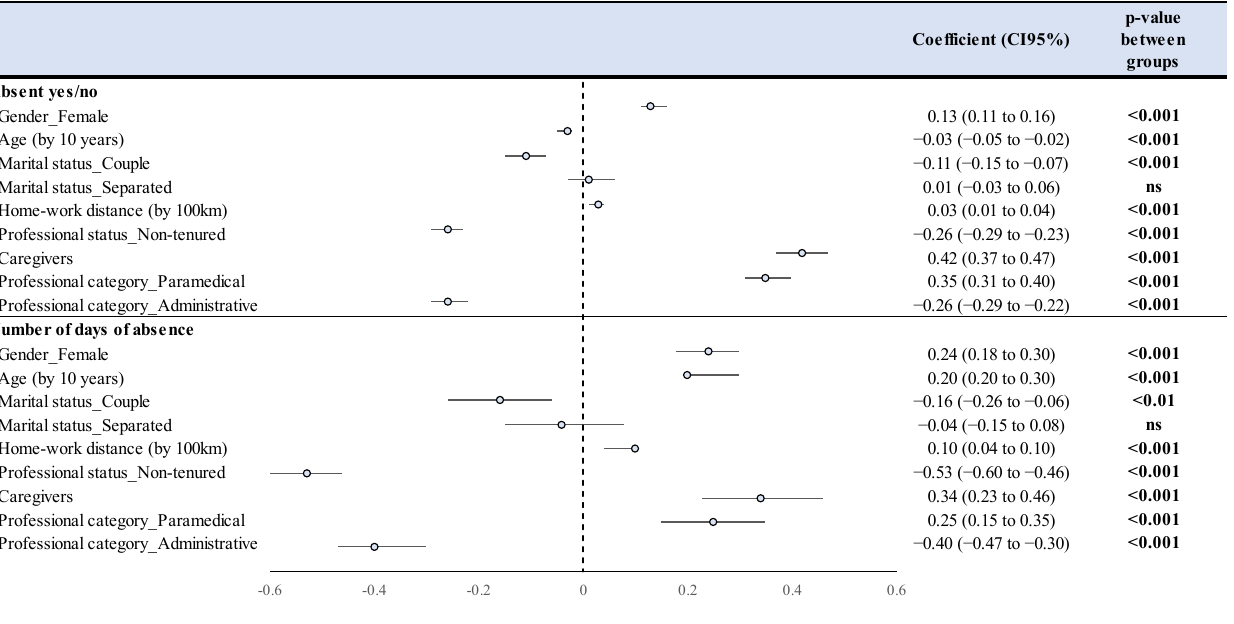
Figure 5. Multivariate analyses of factors influencing the occurrence of absences and the number of days of absence.